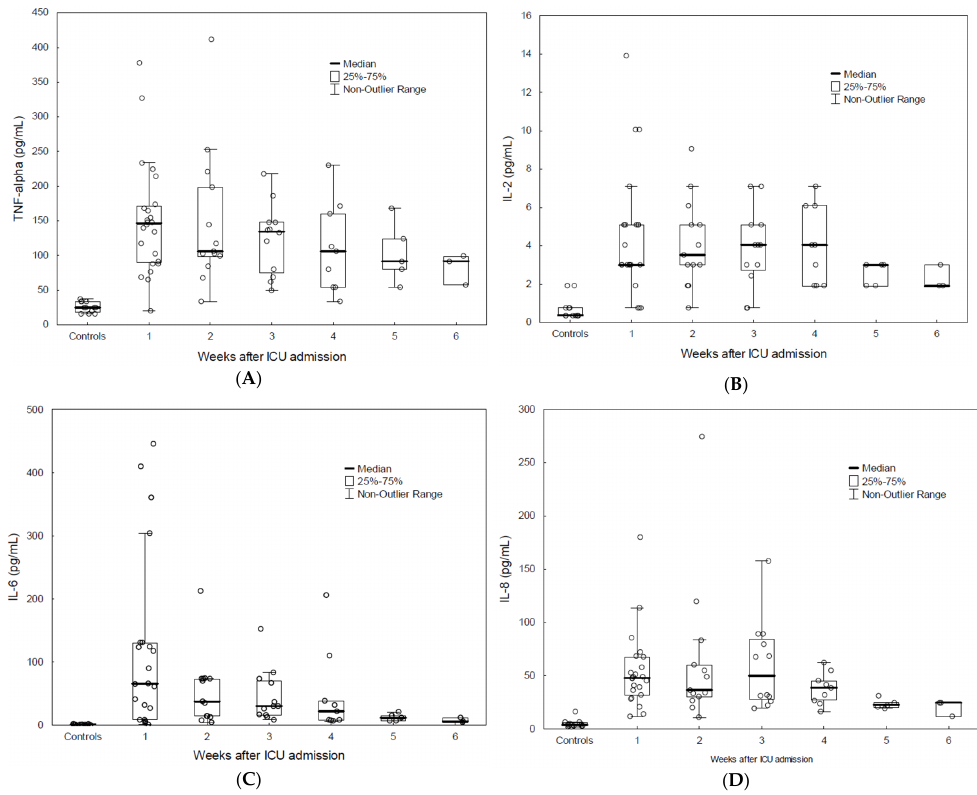
Plasma levels of TNF α , IL-2, IL-6, IL-8, IL-10 ( p < 0.001), IFN γ ( p < 0.01), and GM-CSF ( p < 0.05) were higher in COVID-19 patients compared to in HCs. No difference was found for IL-4 (Figure 2).